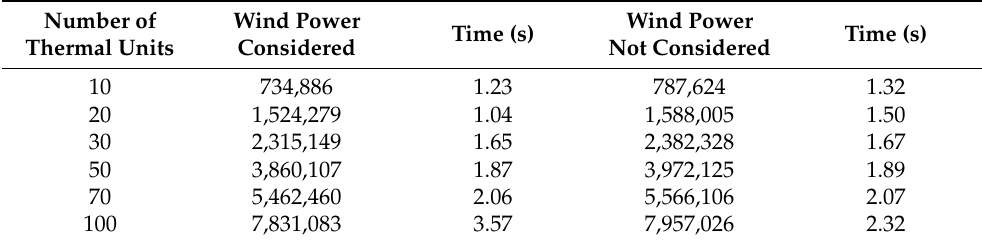
Table 2. Comparison of total system cost (USD) of two UC